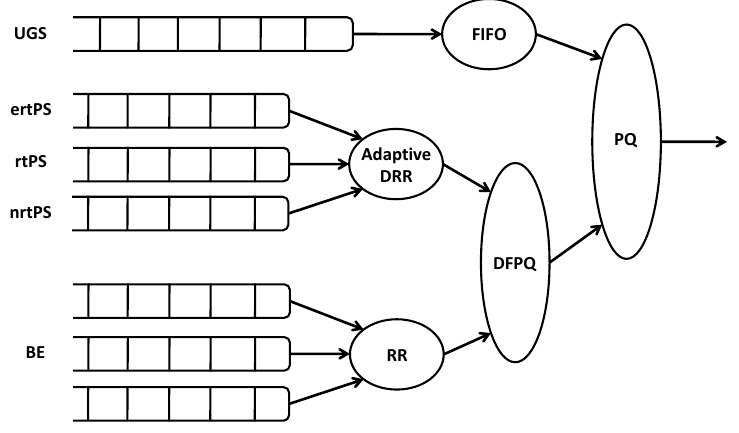
Figure 8. Hierarchical WiMAX scheduling algorithm of an RPR/WiMAX interface